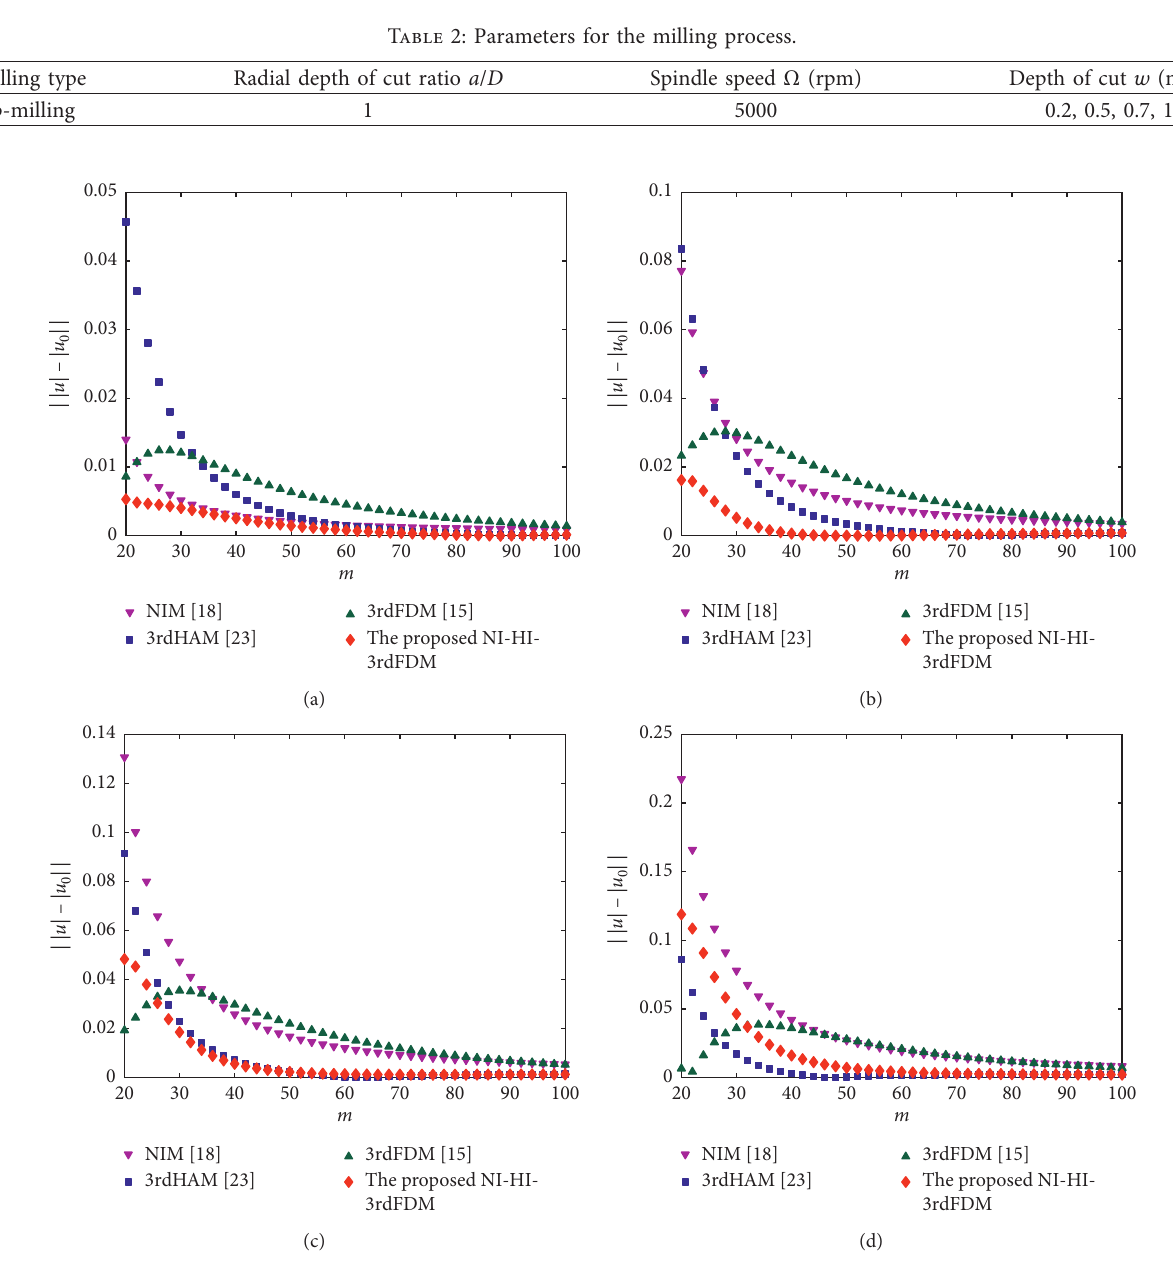
Figure 1: Convergence rate for the NIM, 3rdHAM, 3rdFDM, and the proposed NI-HI-3rdFDM. (a) w � 0.2 mm, | u | � 1 . 0726; (c) w � 0.7mm, | u w � 0.5mm, | u 0